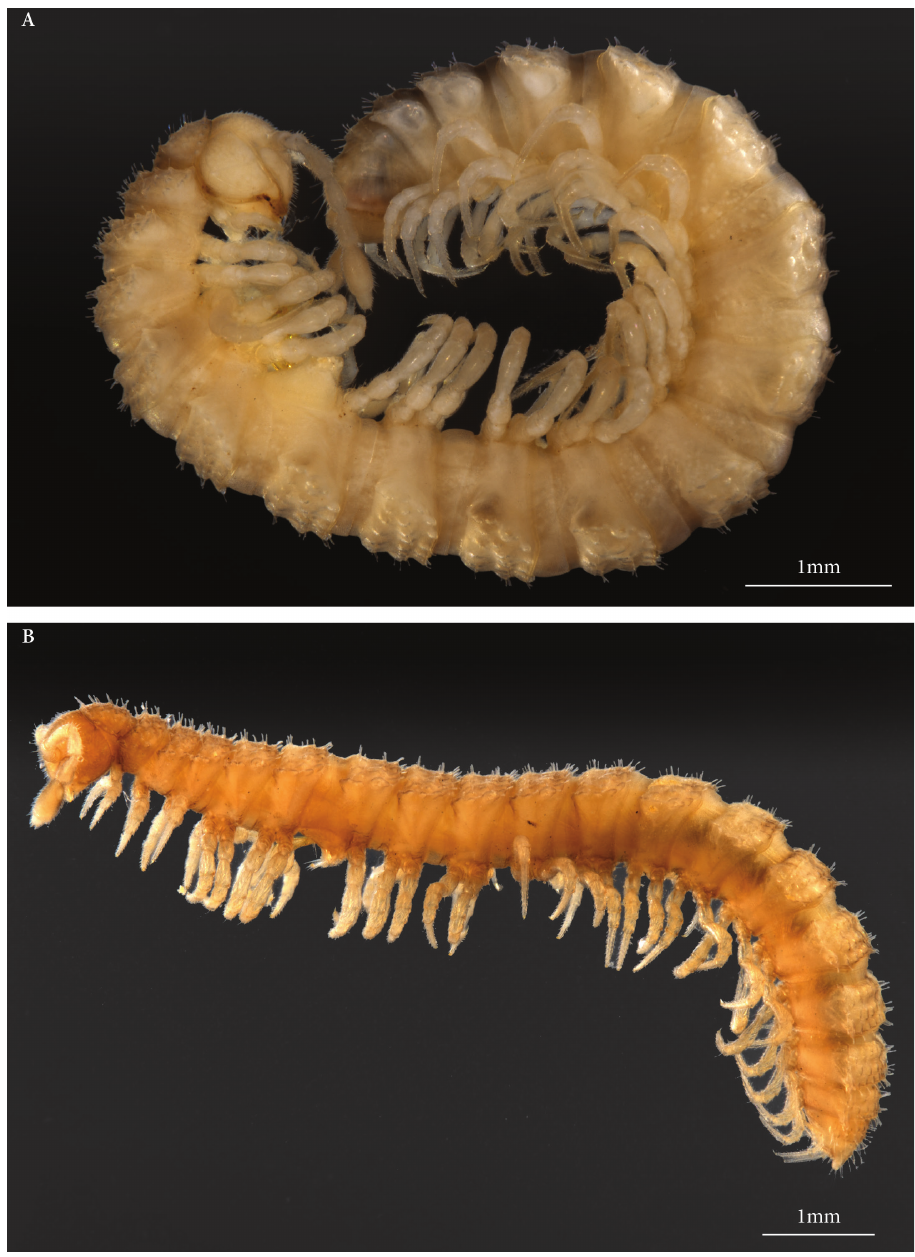
Figure 4. Heterocookia novator (Silvestri, 1896) and Heterocookia tunisiaca Ceuca, 1967, habitus. A Heterocookia novator (Tunisia, Gov. Béja, Jebel El Jouza Amdoun, coll. & det. N. Akkari, MNHN) B Heterocookia tunisiaca (Algeria, wilaya El Tarf, El Kala, coll. Kahina Houd-Chaker, det. J.-J. Geoffroy,